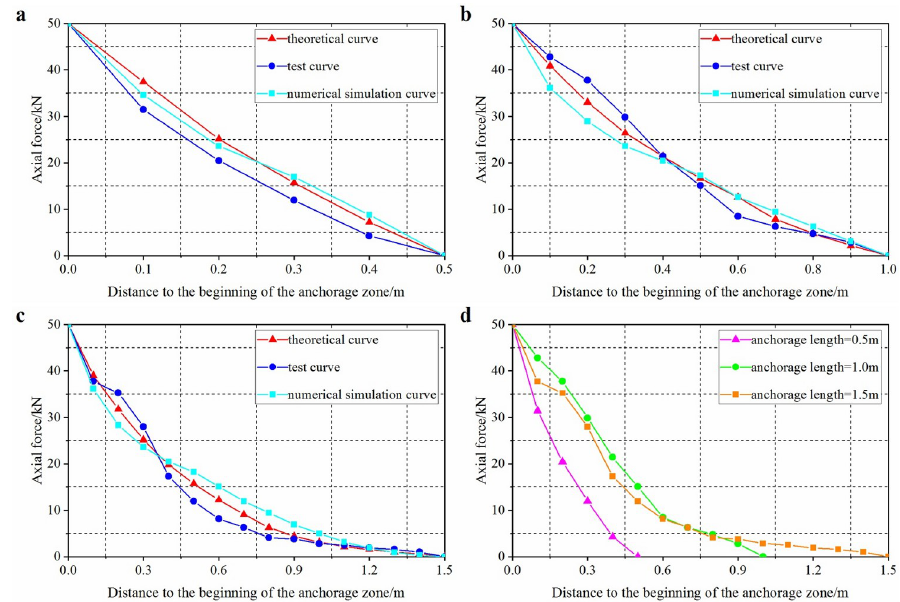
Fig 10. Axial stress distributions in anchorage zone with different anchorage lengths and a given pull-out force. Anchorage lengths of 0.5 m (a), 1.0 m (b), and 1.5 m (c), (d) is test curves of three length.